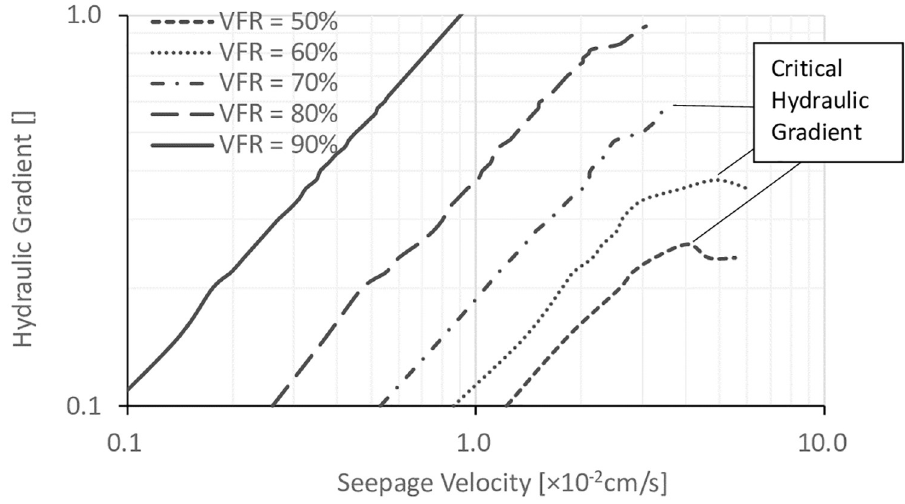
Fig 7. The relationship between the hydraulic gradient and the seepage velocity for specimens with different VFR values and D c =